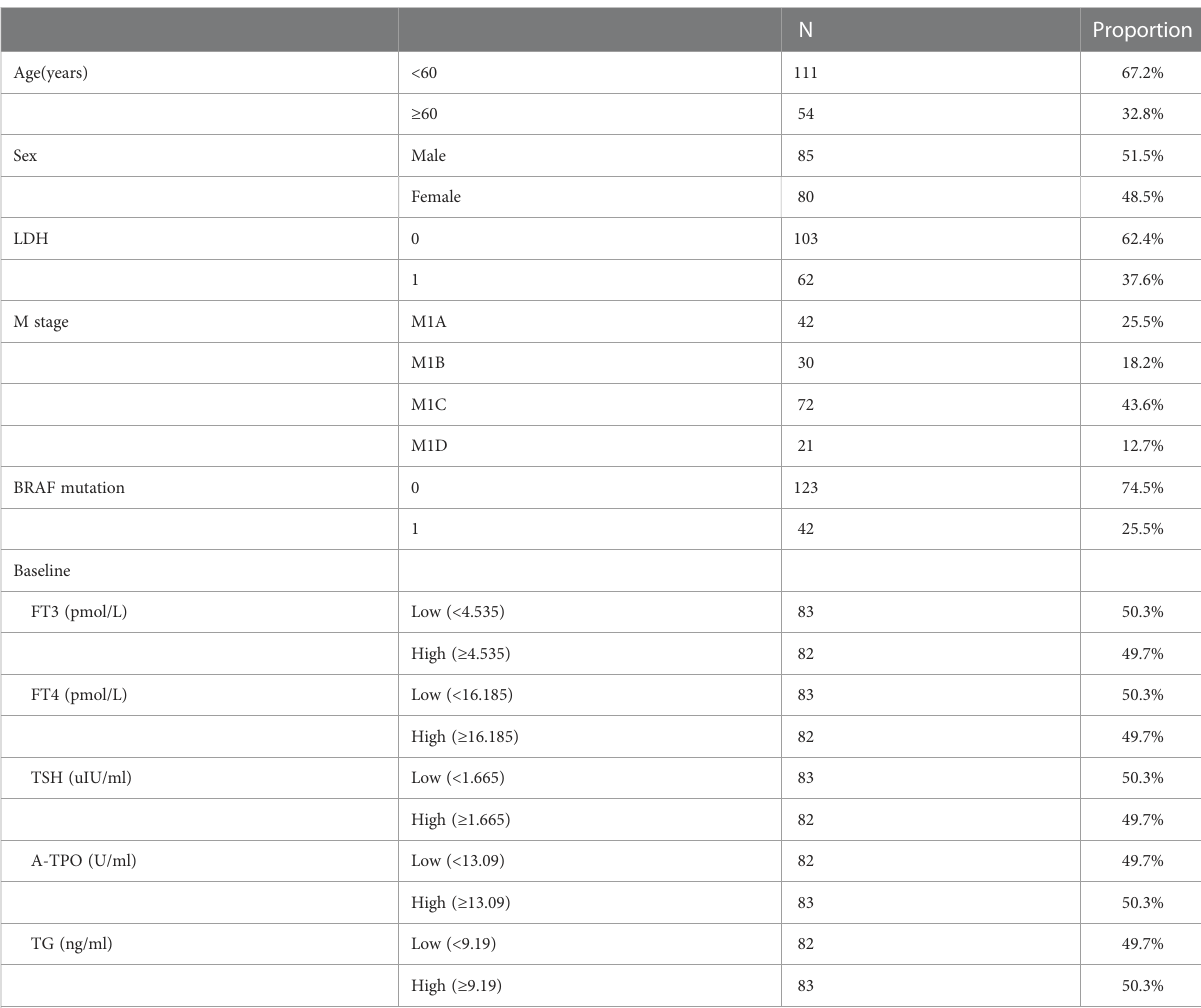
TABLE 1 Patient baseline